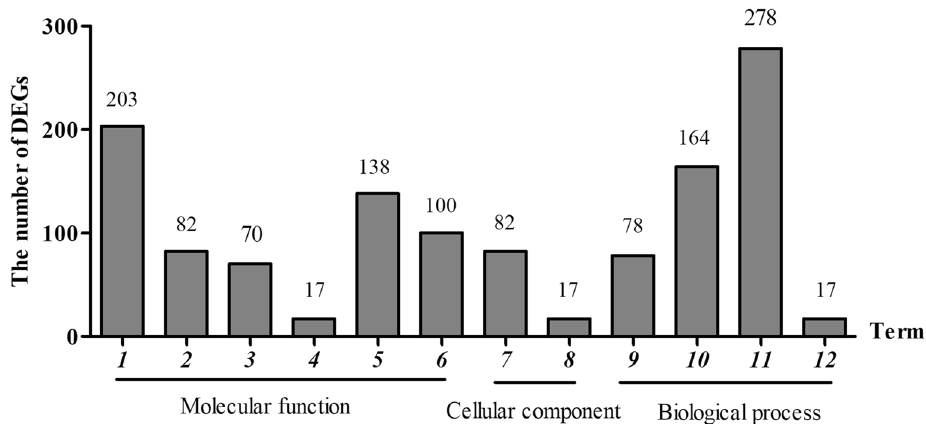
Figure 4. GO enrichment of DEGs. 1. DNA binding. 2. Structural constituent of ribosome. 3. Hydrolase activity. 4. Xyloglucan: xyloglucosyl transferase activity. 5. Oxidoreductase activity. 6. Transcription factor activity; sequence-specific binding. 7. Ribosome. 8. Apoplast. 9. Translational elongation. 10. Regulation. 11. oxidation–reduction process. 12. Cellular glucan metabolic